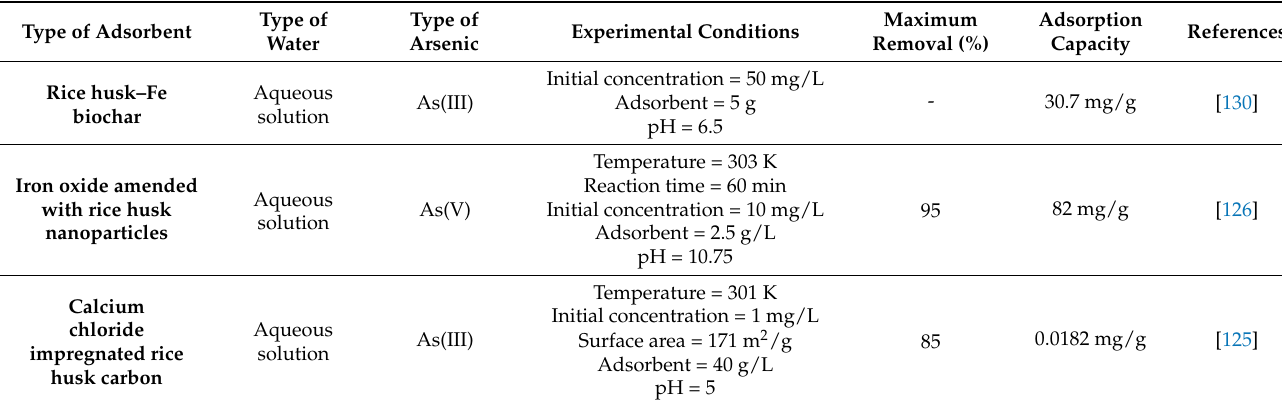
Table 11. Adsorption capacities of arsenic by synthesized rice